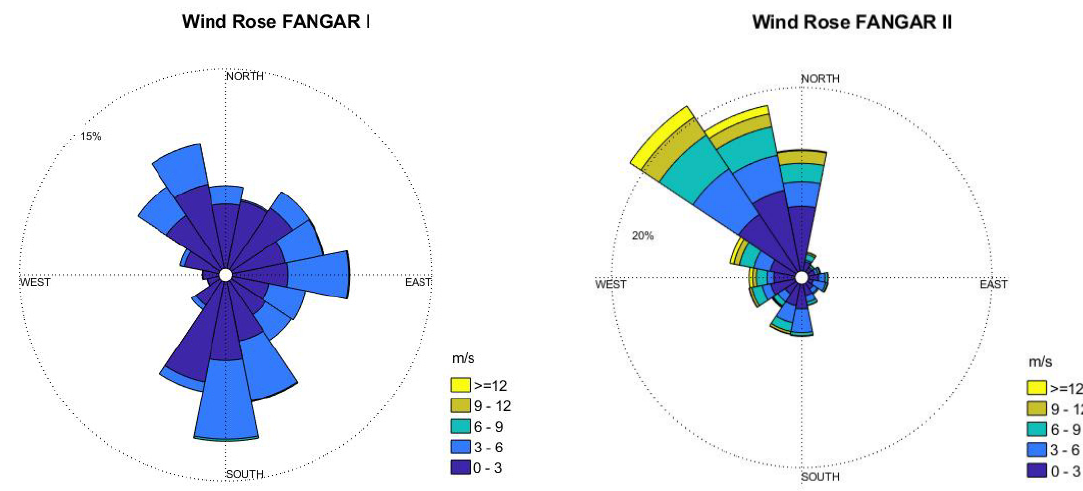
Figure 3. Wind roses of mean velocity for FANGAR-I ( left ) and FANGAR-II ( right ) during both campaigns. Wind intensities are grouped by intervals of 3 m · s − 1 .